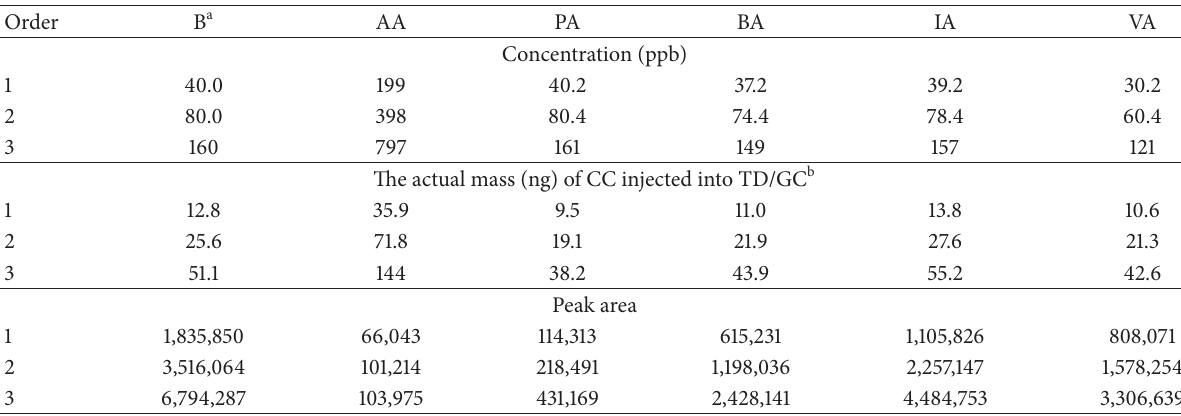
Table 3: Comparison of TD/GC/MS-based calibration analysis of CC using both standard